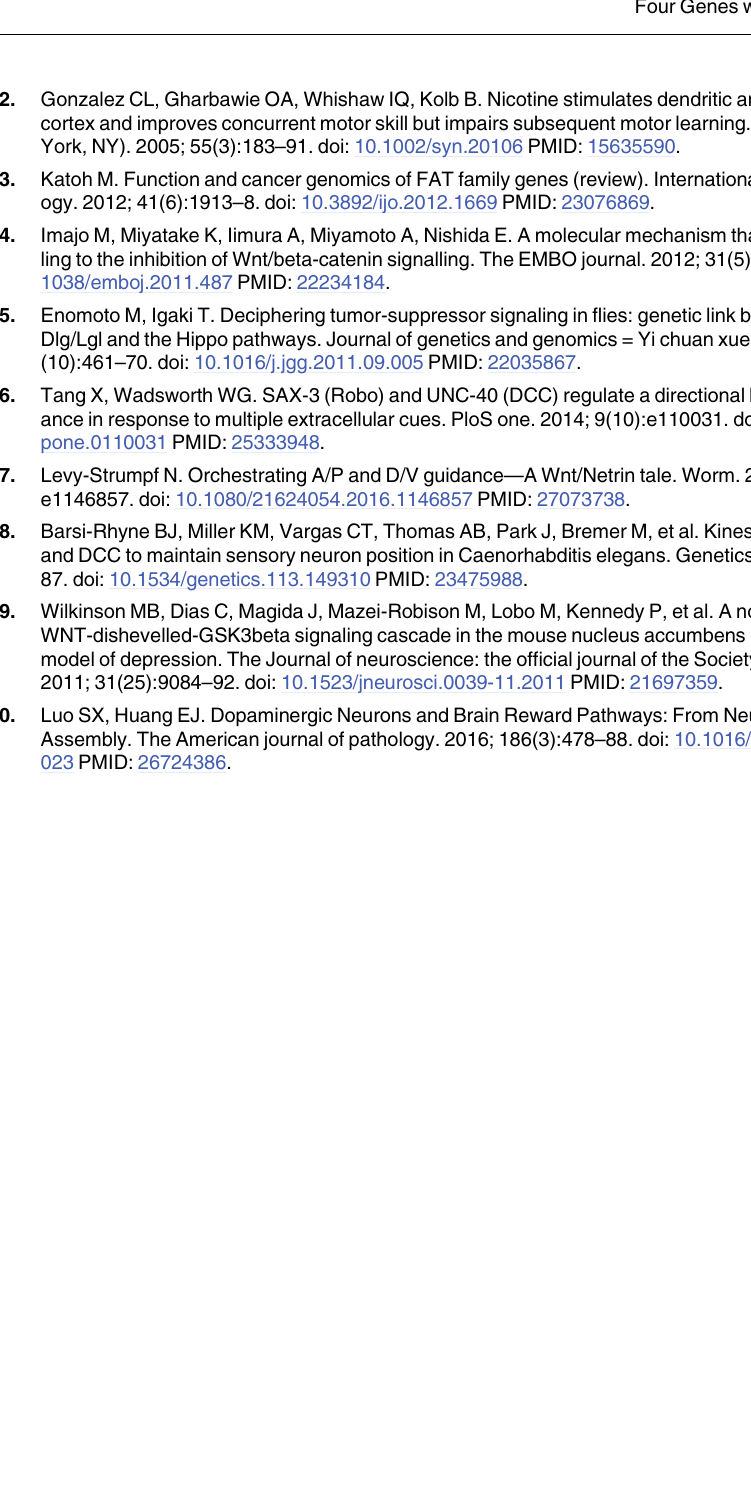
PLOS ONE | DOI:10.1371/journal.pone.0163668 September 27,